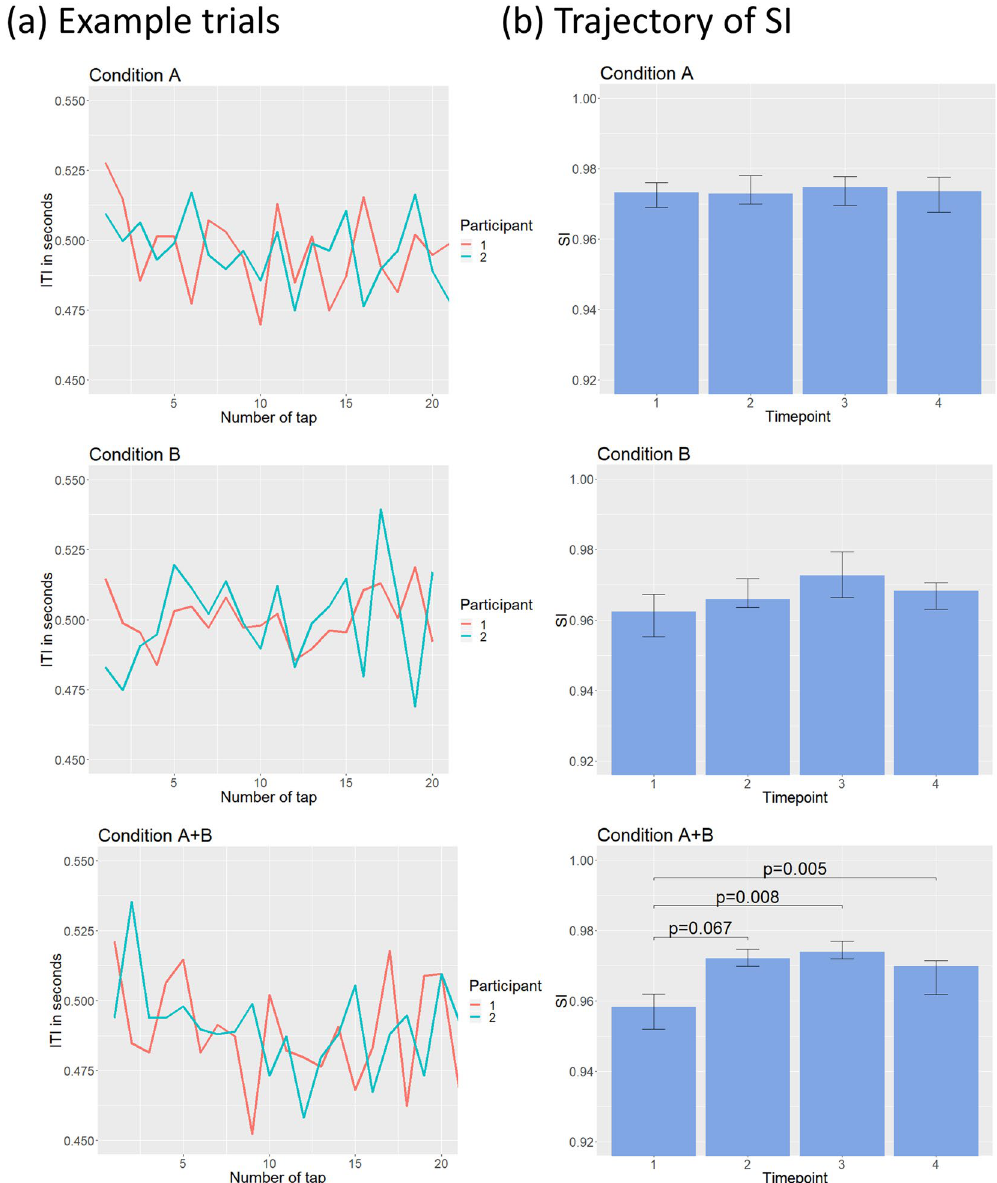
Figure 5. In ( a ) representative trials from one dyad are plotted as the intertap interval in seconds over the number of taps, for the three conditions. In ( b ) we show the trajectory of the SI over four timepoints. The timepoints represent the median SI over four equal subdivisions of the taps for each trial. Error bars are bootstrapped 95% confidence intervals. P-values are obtained from a Tukey’s HSD test.